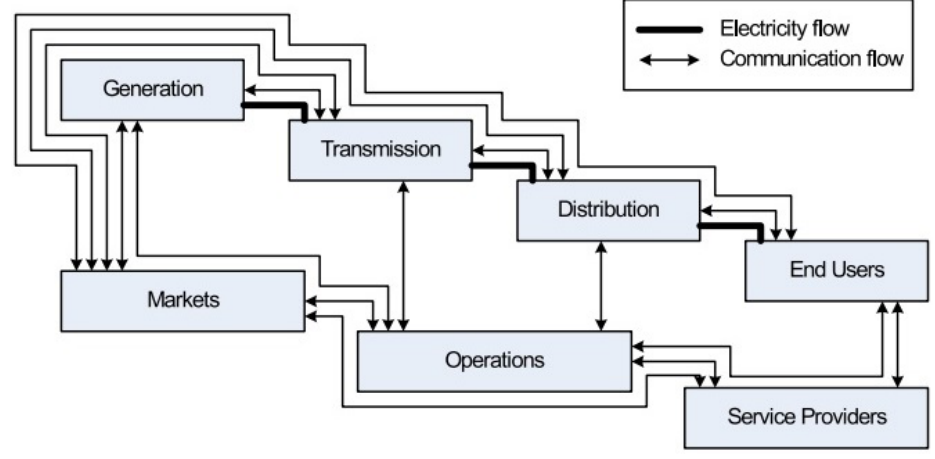
Figure 1. Conceptual diagram of smart grid